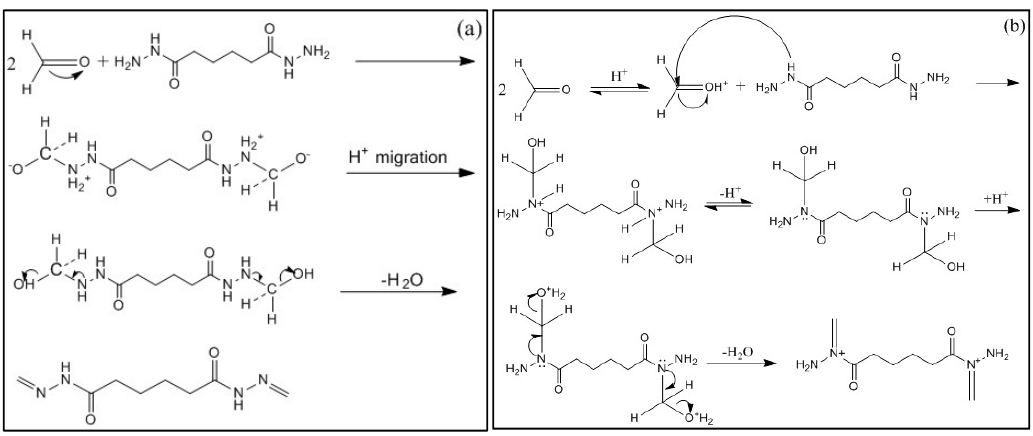
Figure 6. Reaction principle diagrams of formaldehyde with ADH, ( a ) primary amine and ( b ) secondary amine.